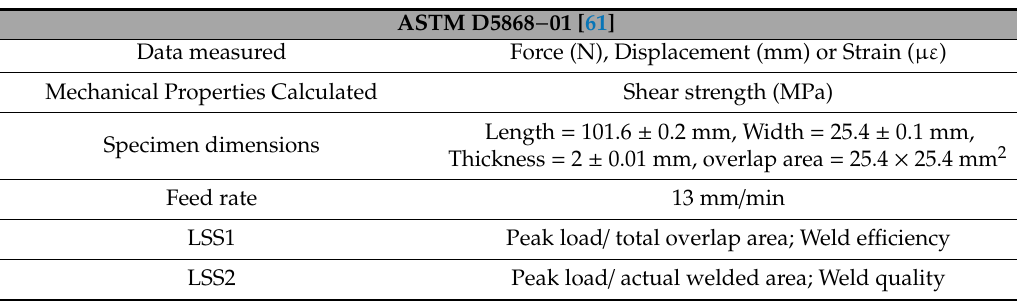
Table 2. Lap shear testing